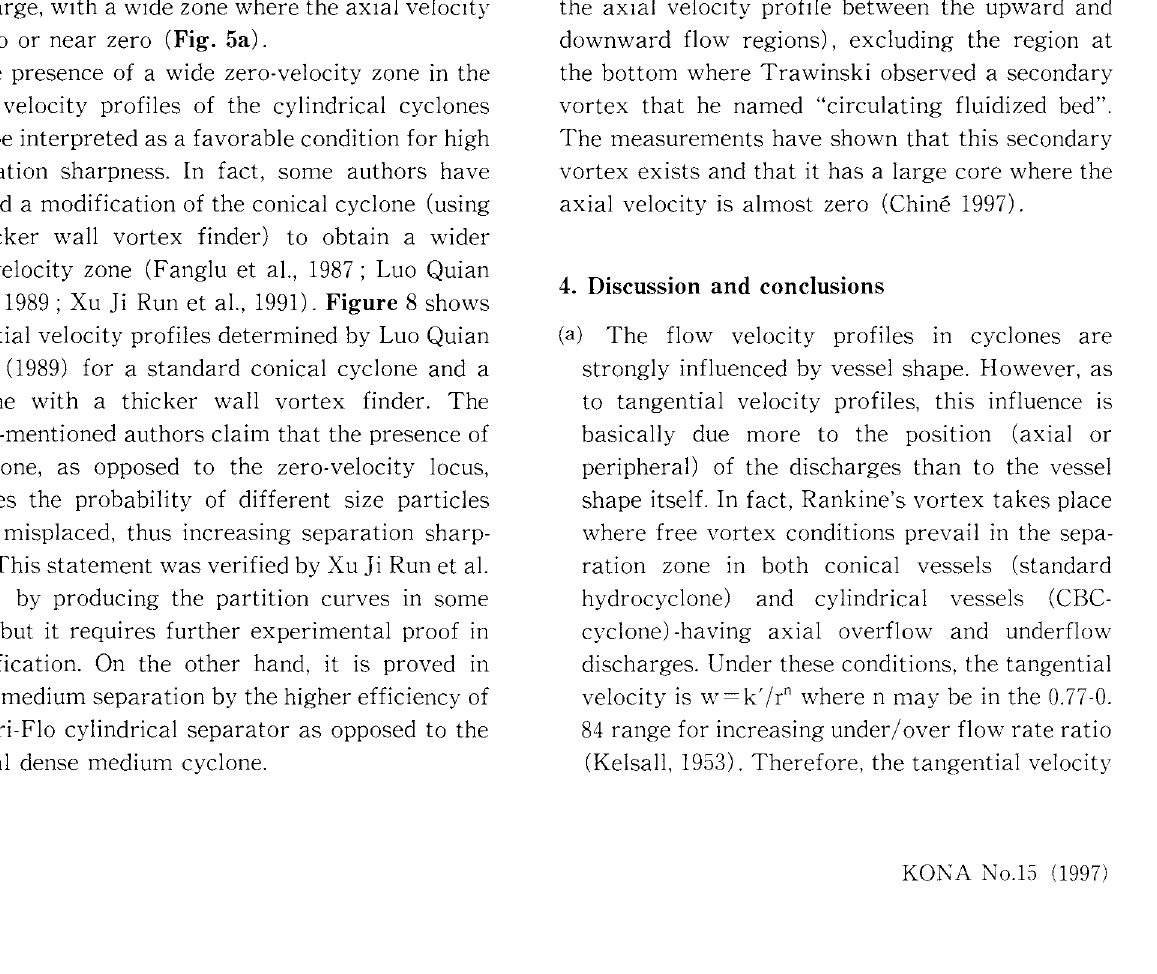
Fig. 7 :\1ean velocity profiles in a cylindrical flat-bottom cyclone: (a) axial component; (b) tangential compo nent.